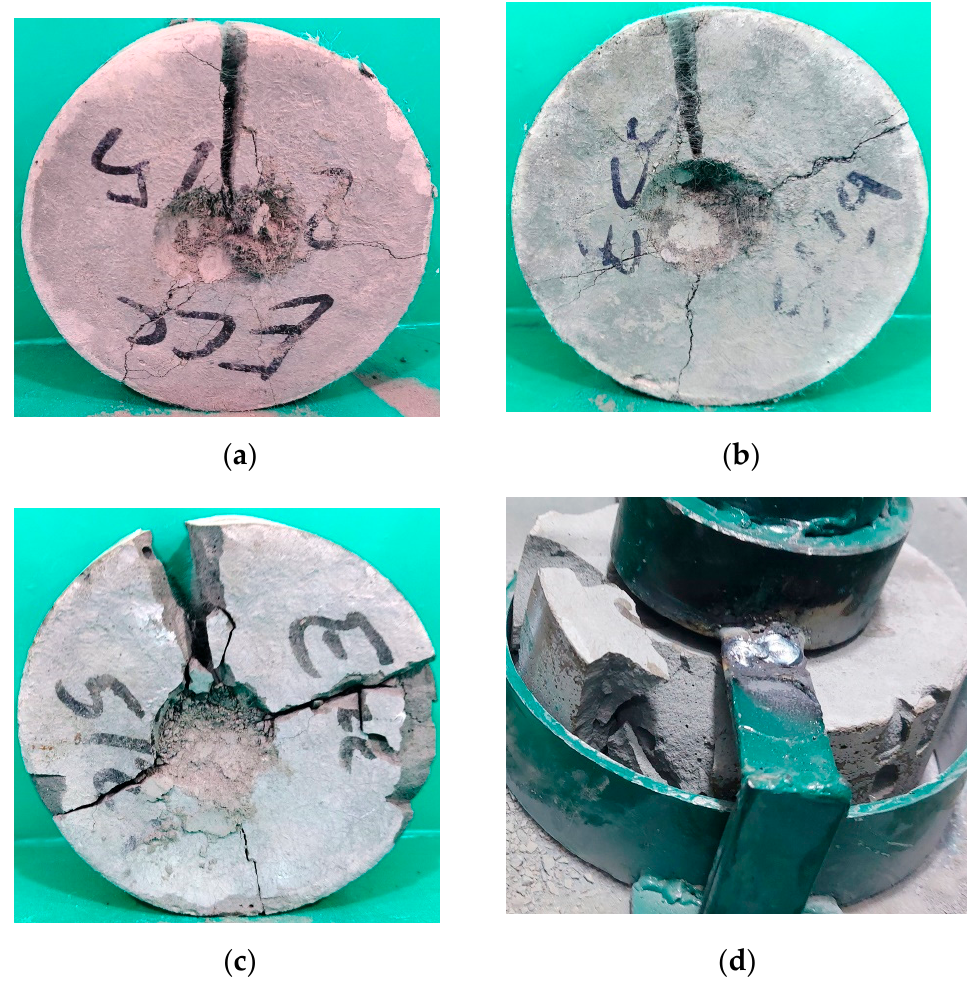
Figure 11. Tested disc specimens after failure ( a ) Reference R, ( b ) 100 °C, ( c ) 200 °C, ( d ) 300 °C.